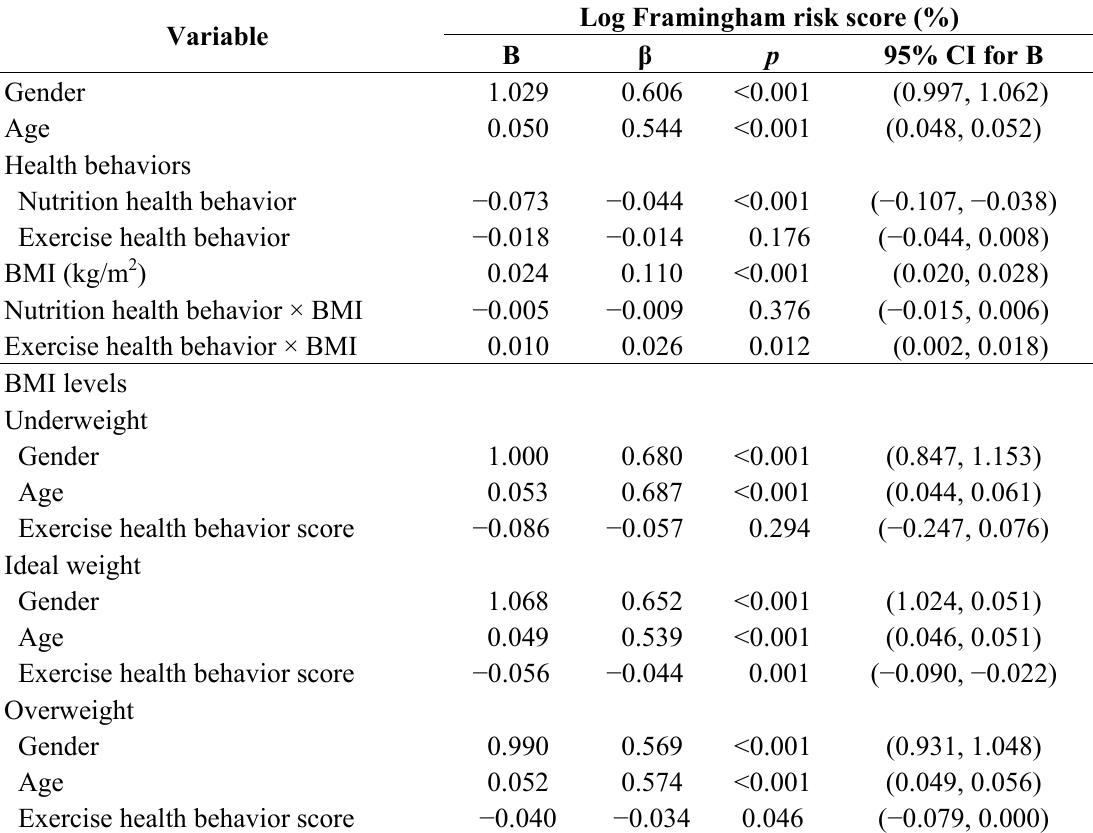
Table 3. Multiple regression models predicting Framingham risk score in relation to nutrition, exercise and